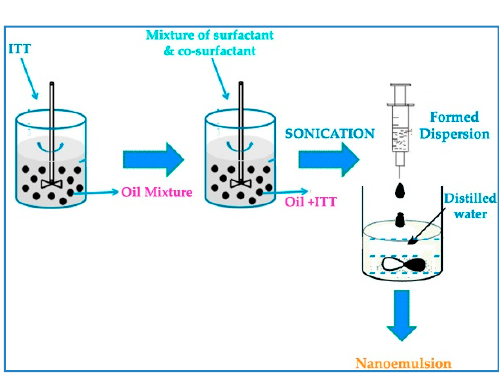
Figure 1. Preparation of ITT nanoemulsion.